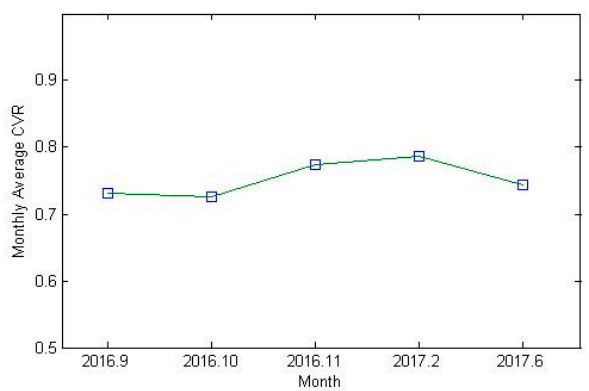
Figure 9. Average CVR factors estimated by applying the MAD direct method, classified by season.